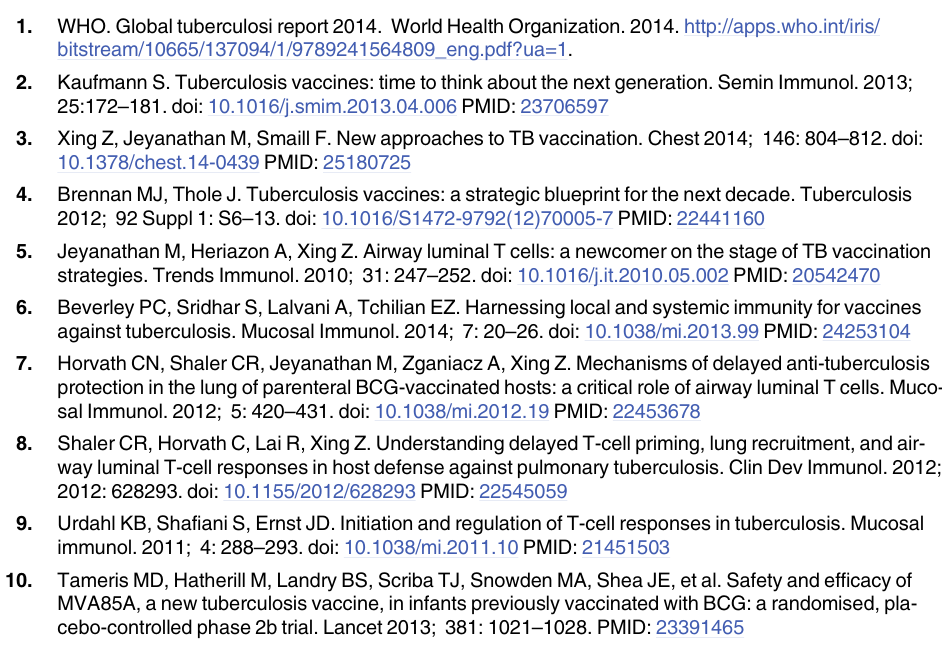
S2 Fig. Gross pathology of M . tb- infected lung. Representative lung images from each group of animals showing gross pathological changes in the lung at necropsy. The lungs of non-vacci- nated controls (non-v) and non-boosted BCG-primed animals (BCG) display severe gross pathology including consolidation, irregular discolorization and scattered nodular lesions. In comparison, gross pathological changes in the lung are markedly reduced in AdHu5Ag85A- boosted animals (BCG/Ad(it), BCG/Ad(aerosol), BCG/Ad(im)). S3 Fig. Longitudinal kinetics of antigen-specific PBMC responses during the course of infection. Antigen-specific IFN- γ responses are measured using IFN- γ ELISOPT assay during the infection phase. Fresh peripheral blood mononuclear cells are stimulated with PPD ( A ) or rAg85A ( B ) or single peptide pool ( C ). Line graphs depict SFCs/million at specified times post- infection expressed as the mean of SFCs ± standard